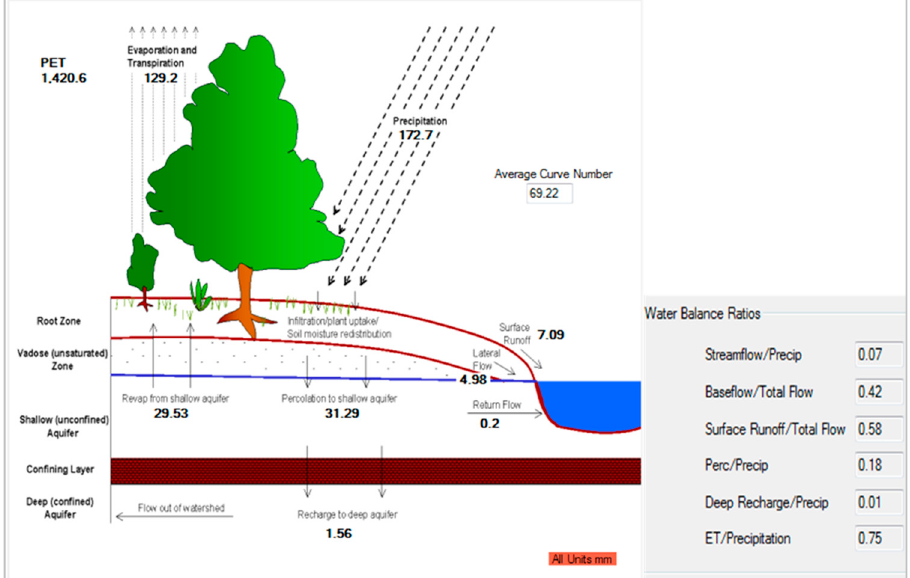
Figure 10. Simulated hydrology and water balance ratios for AZB for the final auto-calibrated model (1973–2015) (All units are in mm).